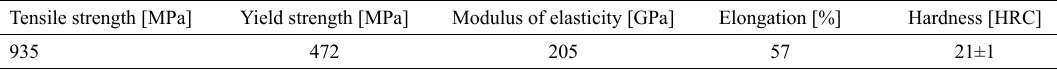
Table 3. Results obtained for the tensile and Rockwell C hardness tests.